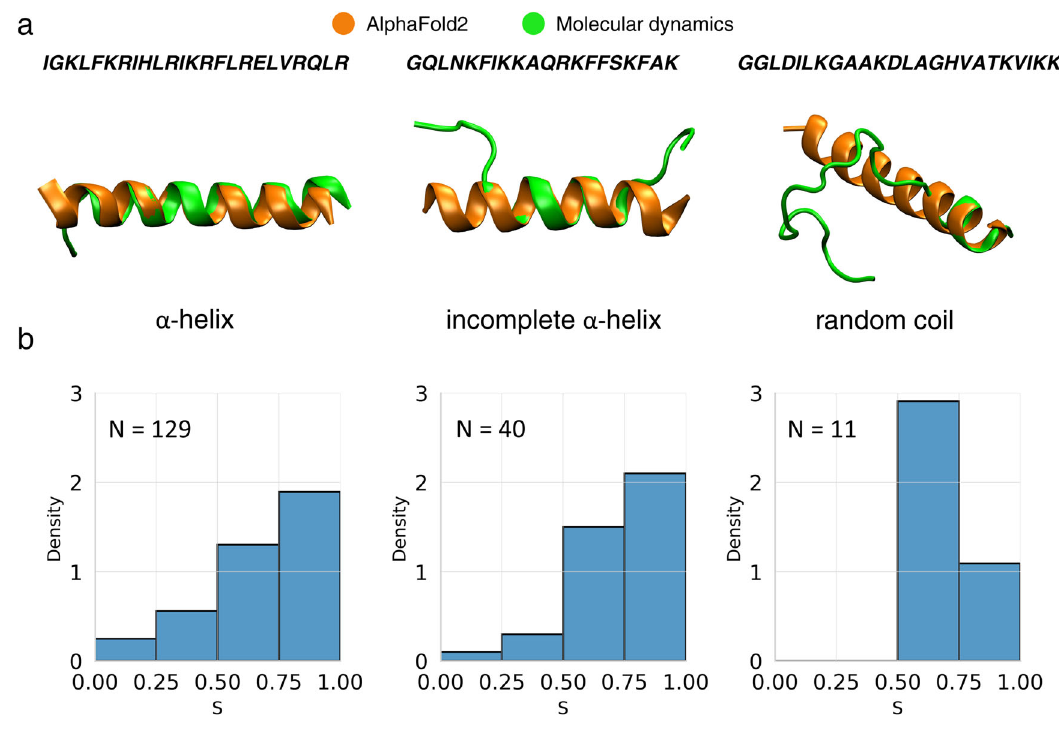
Fig. 8 | Peptide structures according to MD simulations and AlphaFold2 pre- dictions.a Lefttoright:representativestructuresforthelast100nsofMDruns,for peptides with average helical content in [0.75, 1], [0.5, 0.75), (0,0.5) range,